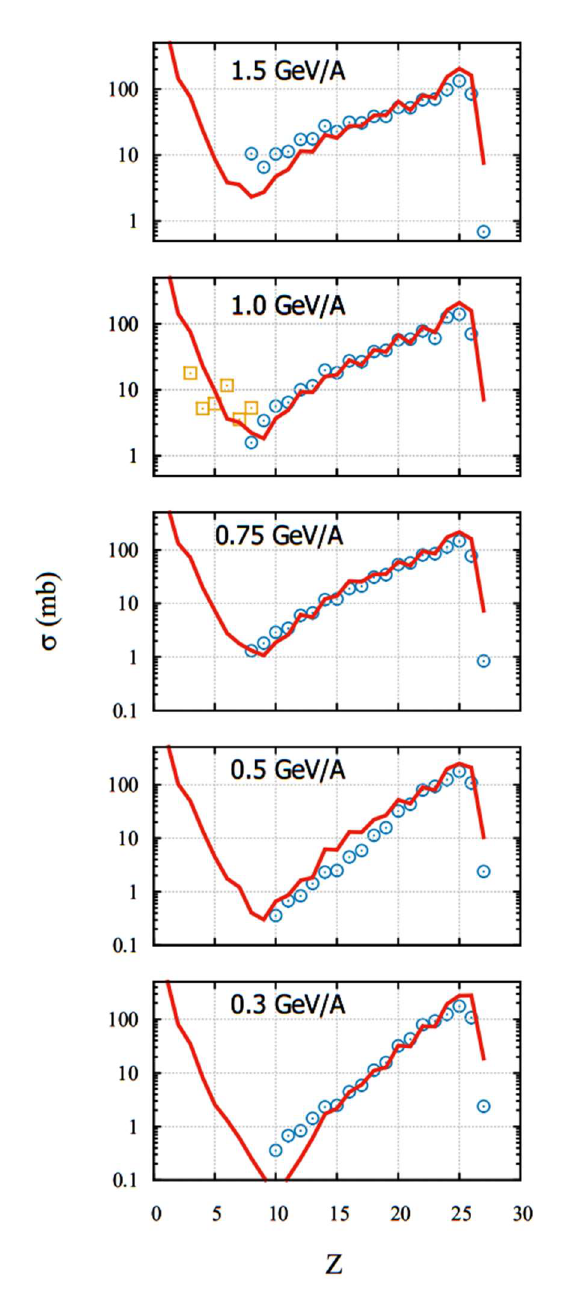
Figure 2. (Color online) Charge distributions of spallation residues in 𝐹𝑒 (cid:2873)(cid:2874) + 𝑝 reactions at bombarding energies of 0.3 - 1.5 GeV/A. Experimental data are shown with symbols. Calculations shown with solid curves are described in the text.